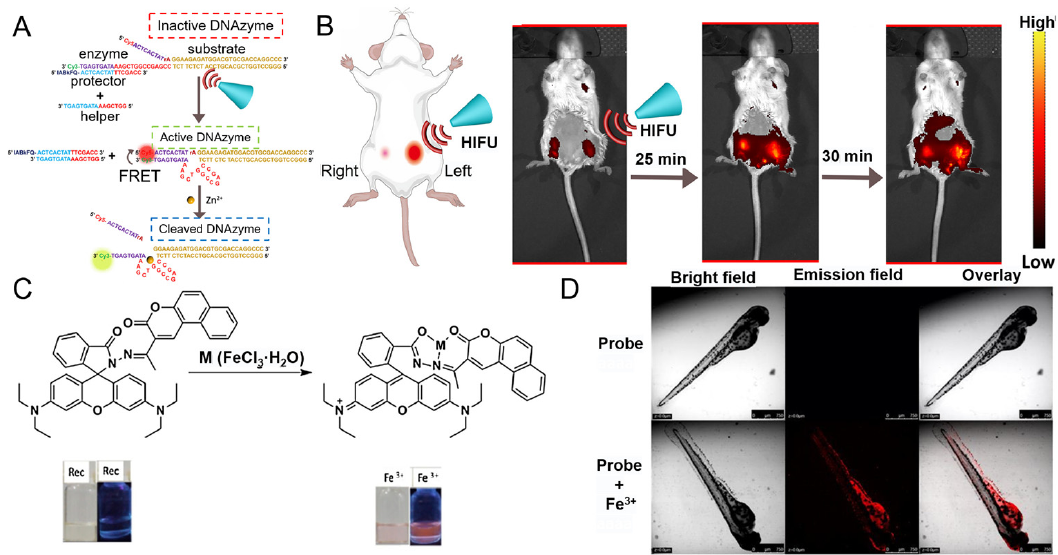
Figure 12. Two representative examples of essential metal ion detection in vivo: ( A ) Schematic of HIFU-activated noninvasive and spatiotemporal control of the DNAzyme-based sensor for Zn 2+ detection in vivo. ( B ) HIFU-activated metal-ion sensing in vivo. Whole-body fluorescence imaging of mice. Reproduced from [172] with permission from the American Chemical Society, copyright 2022. ( C ) Proposed sensing mechanism of the probe for the Fe 3+ -sensing event. ( D ) Confocal fluorescence images of zebrafish embryos (3 days old).